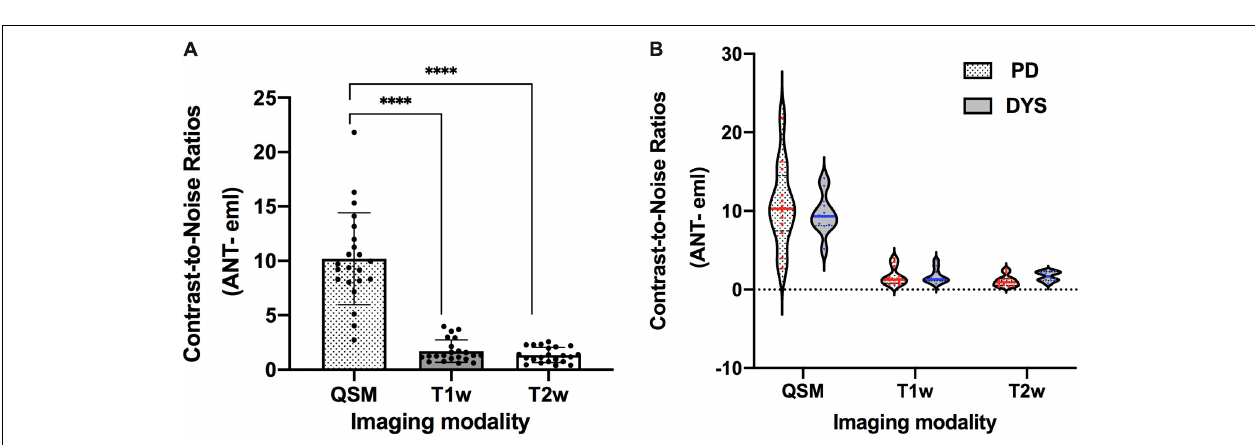
FIGURE 3 | Comparison of the visualization of the ANT on 3 T QSM, T2w, and T1w. Coronal slice views (upper row) and enlarged views of the ANT (lower row) on QSM, T2w, and T1w at one representative section on a representative patient. QSM, quantitative susceptibility mapping; ANT, anterior nucleus of the thalamus.